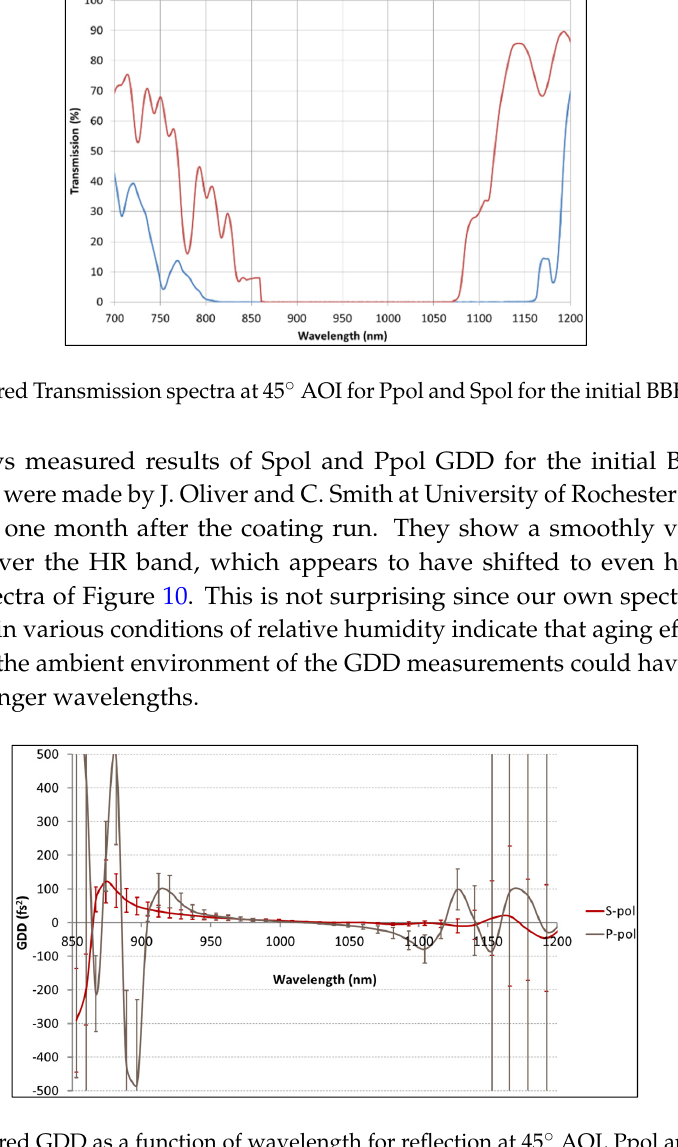
Figure 11. Measured GDD as a function of wavelength for reflection at 45° AOI, Ppol and Spol, for the initial BBHR test